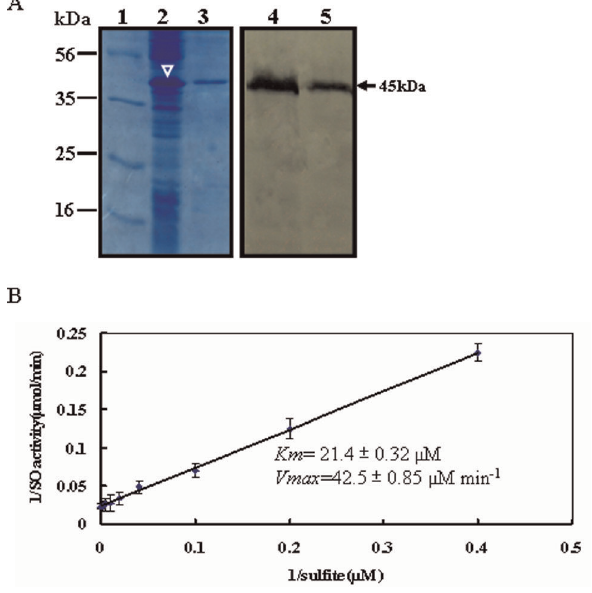
Figure 1. Expression, purification and kinetic analysis of recombinant maize sulfite oxidase. (A) Purification of histidine- tagged maize SO. The histidine-tagged ZmSO (with a predicted molecular mass of 45 kDa) was overexpressed in bacterial cells induced by isopropyl- b -D-thiogalactopyranosid (lane 2, indicated by white arrowhead). The overexpressed protein was purified using metal chelate affinity chromatography (lane 3). The overexpressed and purified SO proteins were confirmed by Western blot with an anti- histidine monoclonal antibody (lane 4 and lane 5; signals marked by an arrowhead). The molecular mass markers (kDa, lane 1) are shown on the left. (B) Steady-state kinetics of recombinant ZmSO with sulfite. Double- reciprocal presentation (Lineweaver-Burk plot) of enzyme rate was conducted using varying concentrations of sulfite (2.5, 5, 10, 25, 50, 100, 200, and 400 m M) and constant 400 m M ferricyanide. The reaction was initiated with 1.0 m g of purified recombinant ZmSO.